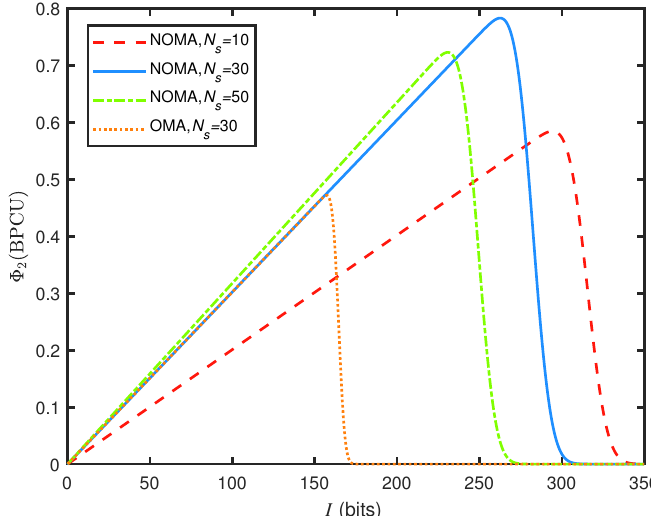
Figure 4. Φ 2 versus the information bits for different schemes and N s .